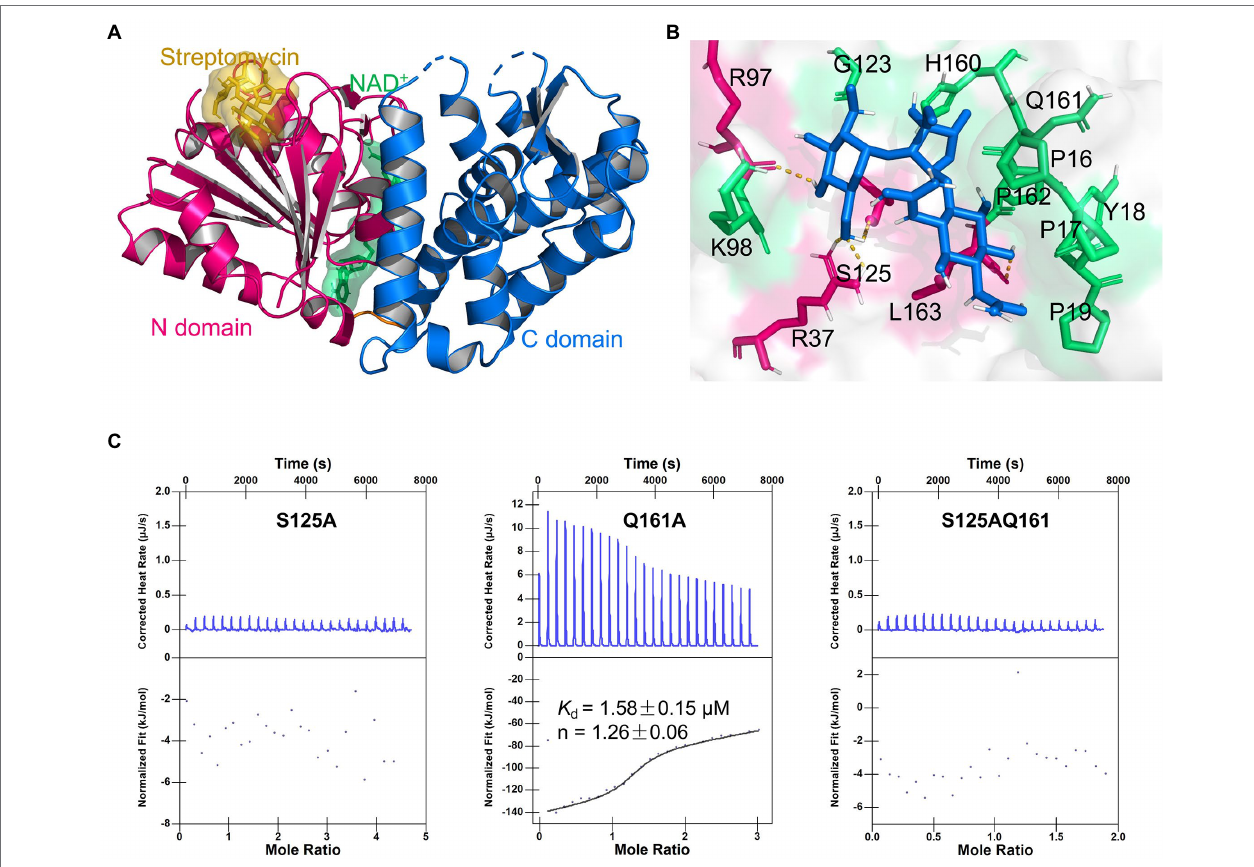
FIGURE 4 | Binding model of DHQS and streptomycin. (A) Streptomycin binds to the proposed site of DHQS. (B) Residues involved in the binding of streptomycin and DHQS. (C) ITC analysis of 1 mM streptomycin binding to 50 μ M mutant proteins (S125A, Q161A, and S125AQ161A). ITC was carried out with 1 mM streptomycin and mutant protein concentration of 50 μ